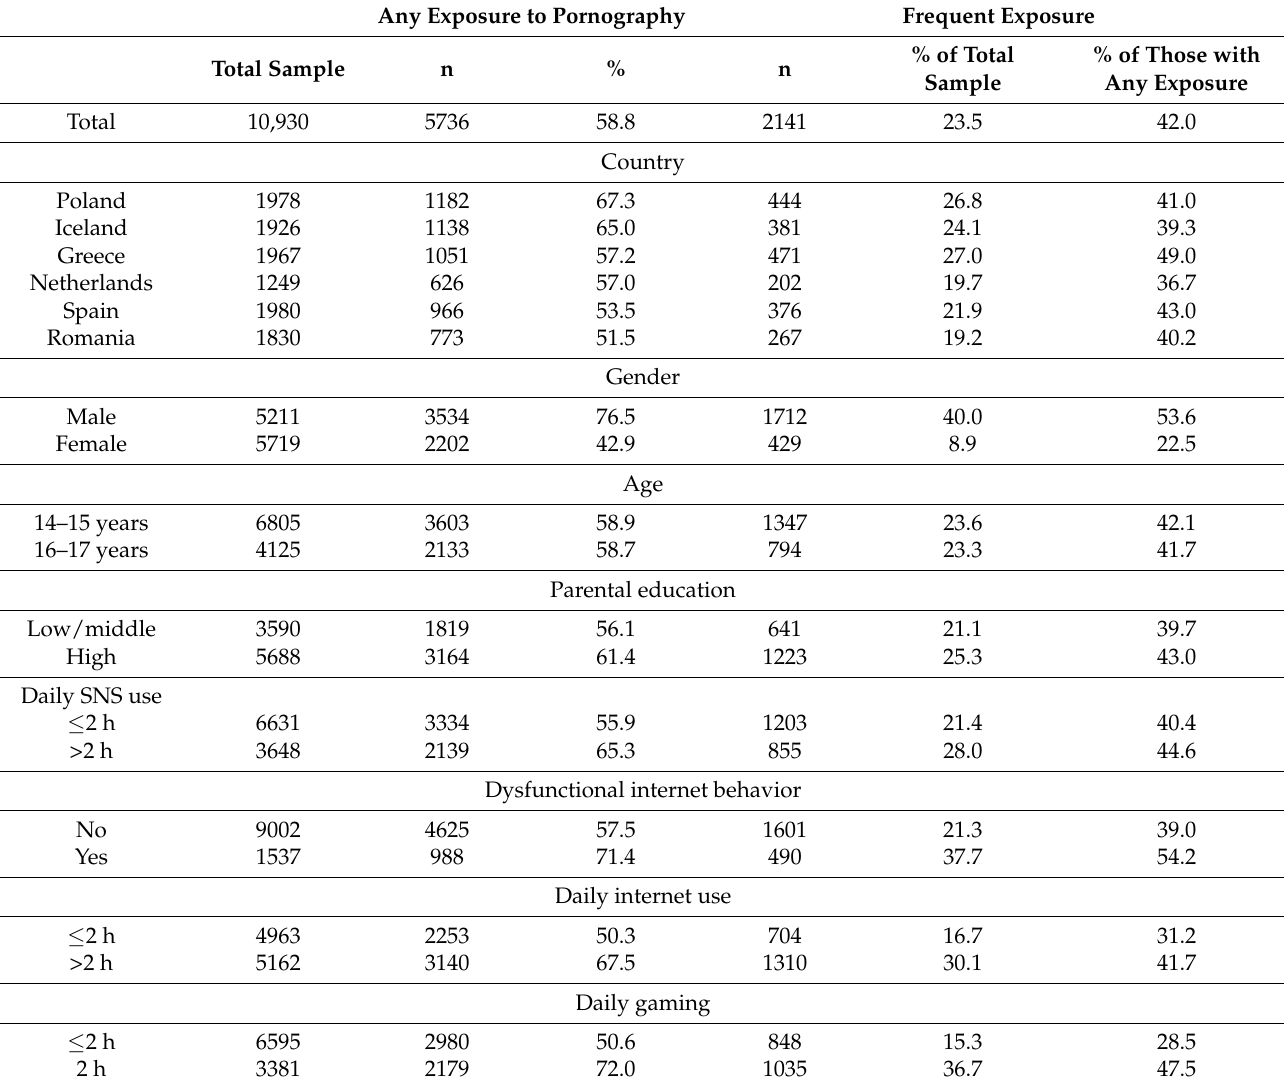
Table 1. Any and frequent (at least once a week) exposure to pornography on the internet in the last 12 months (% based on valid responses)